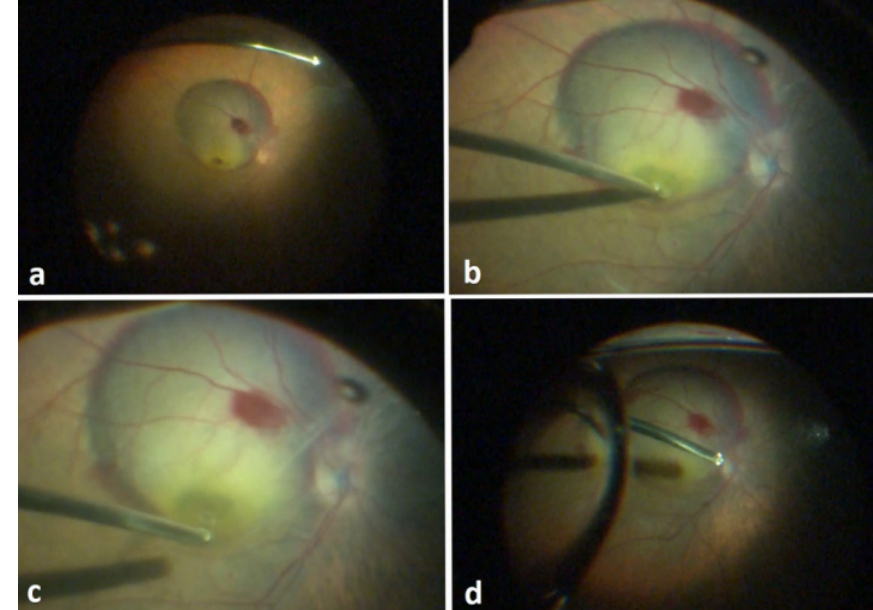
Figure 2: Surgical steps: a) Macular hole, submacular hemorrhage, and arterial macroaneurysm are present; b) ILM peeling; c) rtPA injection using vitrectomy probe via the macular hole, and extension of the submacular hemorrhage area after injection of rtPA; d) Fluid-air exchange at the end of the